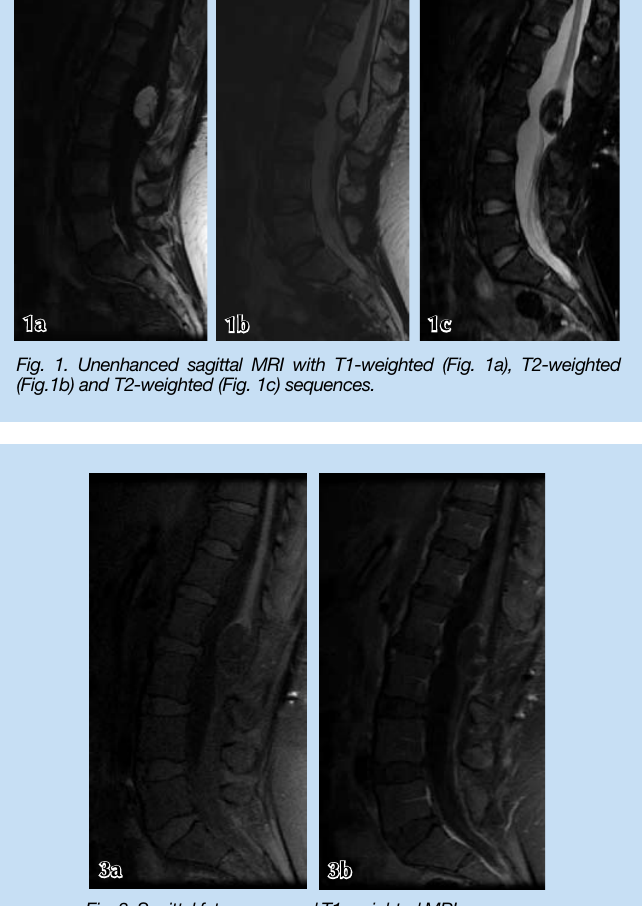
Fig. 3. Sagittal fat-suppressed T1-weighted MRI sequences; pre-gadolinium (Fig. 3a) and post-gadolinium (Fig.